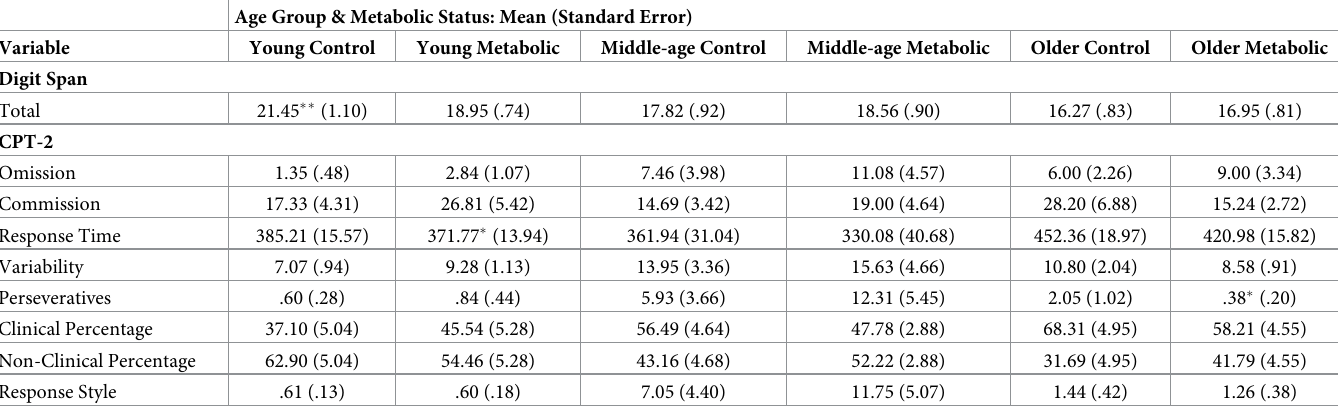
Table 7. Relationship between age, metabolic status, and cognitive functioning. Age Group & Metabolic Status: Mean (Standard